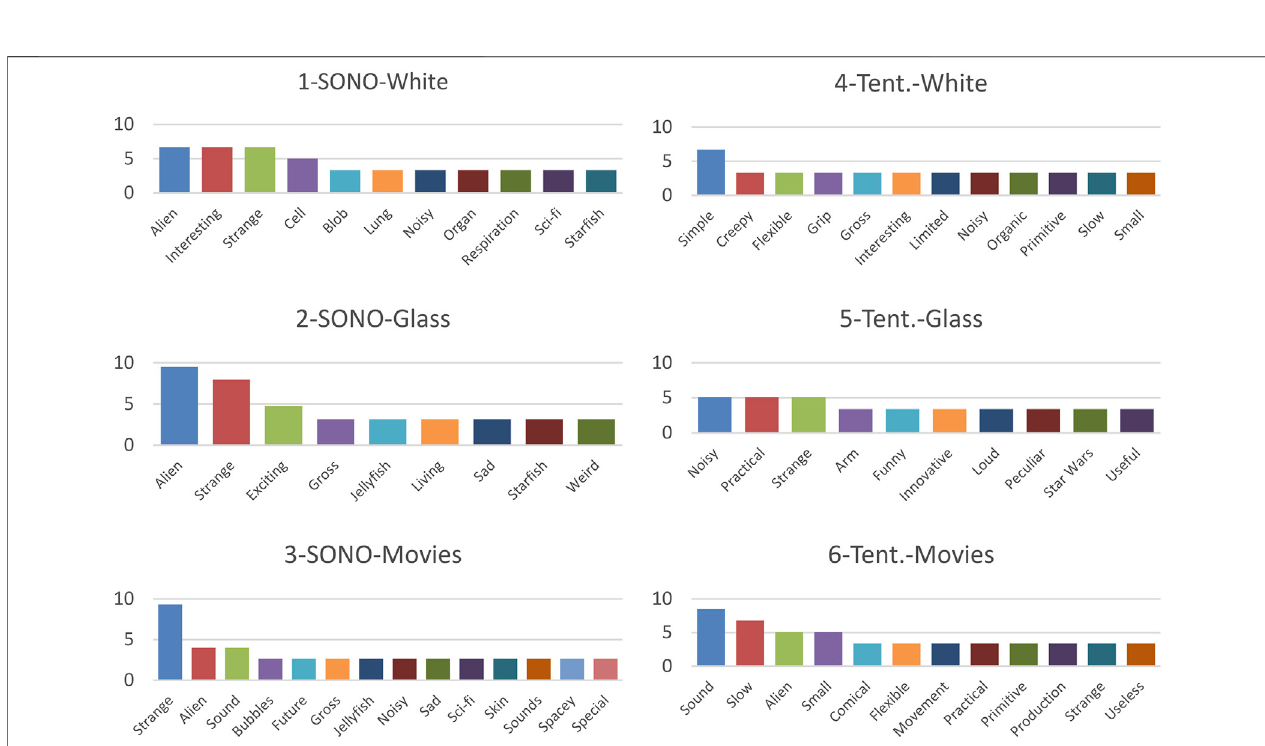
FIGURE 7 | Most frequent words used by participants. The y -axis gives percentage of word occurrence frequency (%).